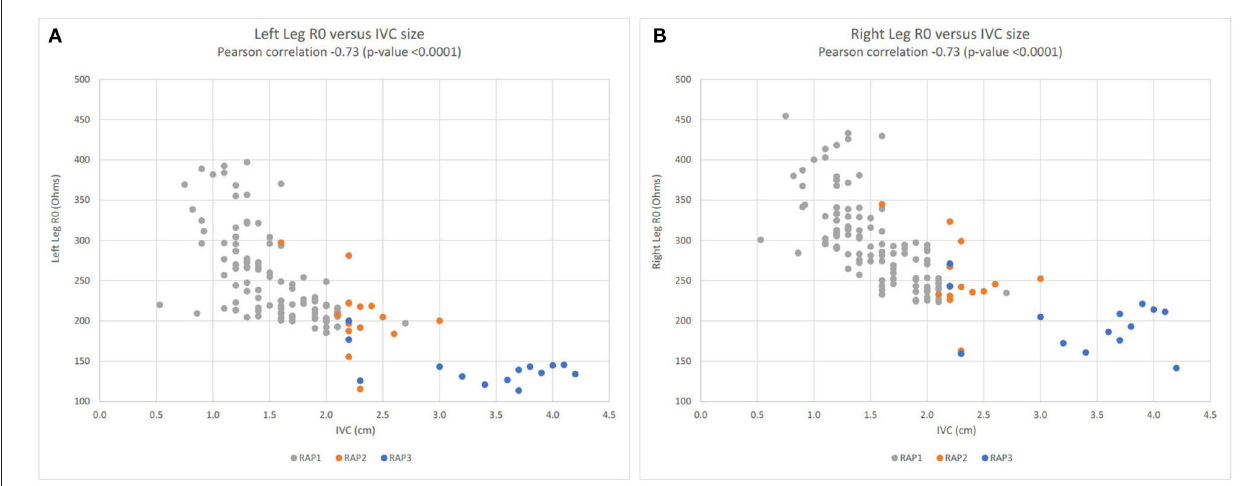
FIGURE 4 | Lower extremity R 0 impedance measurements vs. inferior vena cava (IVC) size; left leg (A) , right leg (B) . Left leg (A) and right leg (B) scatter plots for R 0 impedance vs. inferior vena cava (IVC) size for the subgroup of 12 heart failure patients enrolled in the IMPEL clinical study (ClinicalTrials.gov identifier NCT02857231). Right atrial pressure (RAP) categories: RAP1 in gray ( < 8 mmHg), RAP2 in orange (8–14.99 mmHg), and in blue RAP3 (15 mmHg). R 0 impedance is inversely related to extracellular fluid volume. Hence, in both legs, lower impedance values are associated with larger IVC size and higher right atrial pressures. R 0 , resistance at zero Hertz; IVC, inferior vena cava; RAP, right atrial pressure; cm, centimeter.